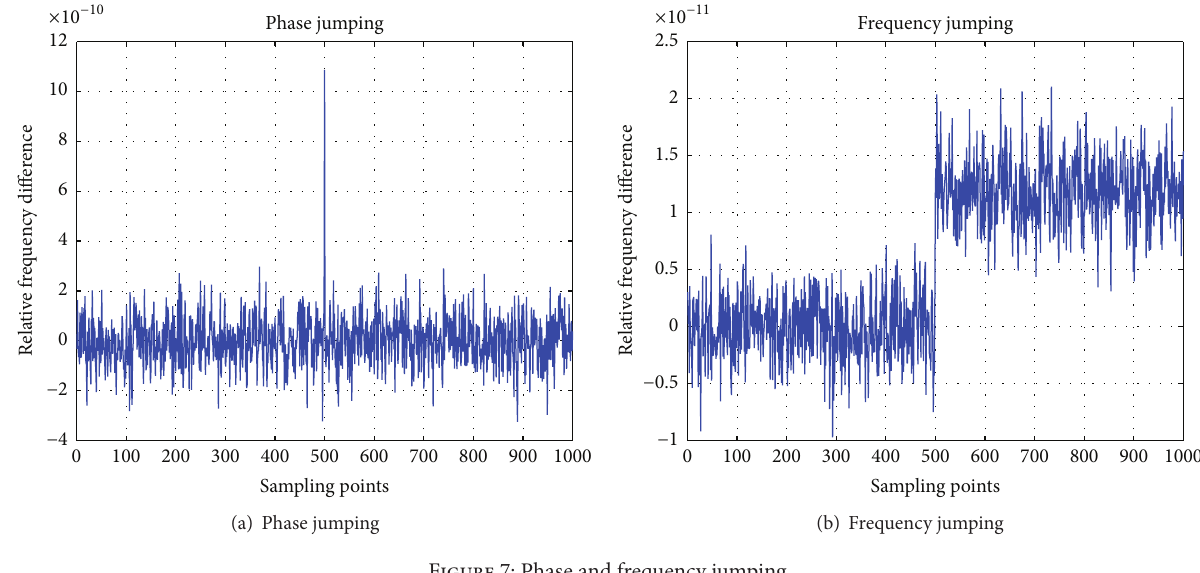
Figure 7: Phase and frequency jumping.